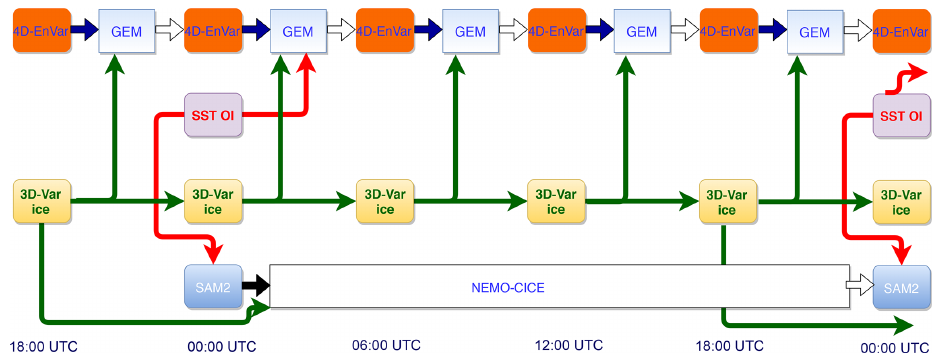
Figure 2. The uncoupled DA system (UNCPL) scheme. The atmospheric 4D-EnVar DA component computes analyses every 6h. The SST OI DA component computes daily analyses valid at 00:00UTC, which initialize the atmospheric GEM model and are assimilated using the daily SAM2 ocean DA component at 00:00UTC. The 3D-Var ice analyses are computed every 6h and are used to initialize the uncoupled 6h atmospheric and 24h oceanic uncoupled forecasts. The uncoupled atmospheric analyses are propagated in space and time using the GEM model. The uncoupled ocean analyses are propagated using the NEMO–CICE model.